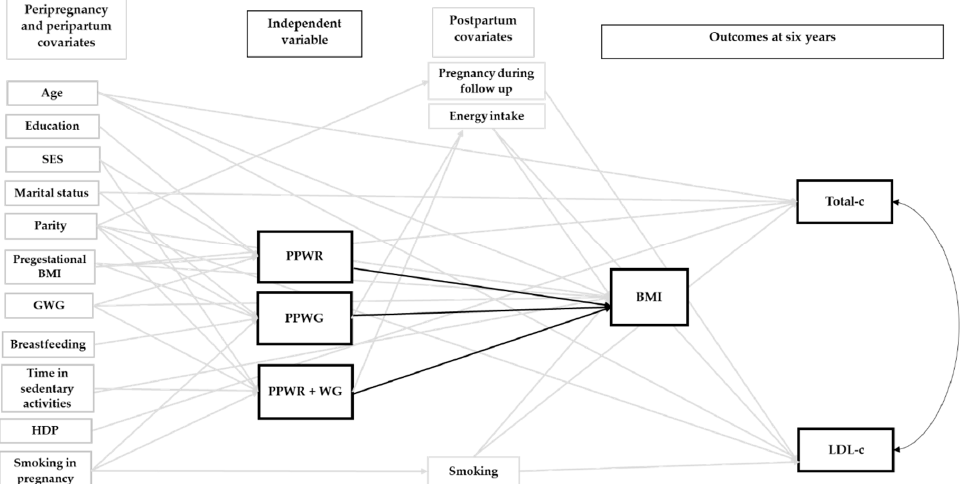
Figure 3. Final path model of the association between patterns of weight change one year after delivery and Outcome Group 3 at six years postpartum. The reference group was women who returned to their pregestational weight by one year postpartum. Arrows represent pathways among variables. The black arrows represent paths relevant to our study objectives. A continuous black arrow indicates a statistically significant association ( p < 0.05). For these outcomes, neither direct nor indirect associations were identified. BMI, body mass index; GWG, gestational weight gain; HDP, hypertensive disorders of pregnancy; LDL-c, low-density lipoprotein cholesterol; PPWG, postpartum weight gain; PPWR, postpartum weight retention; PPWR + WG, postpartum weight retention + weight gain; SES, socioeconomic status; total-c, total cholesterol.